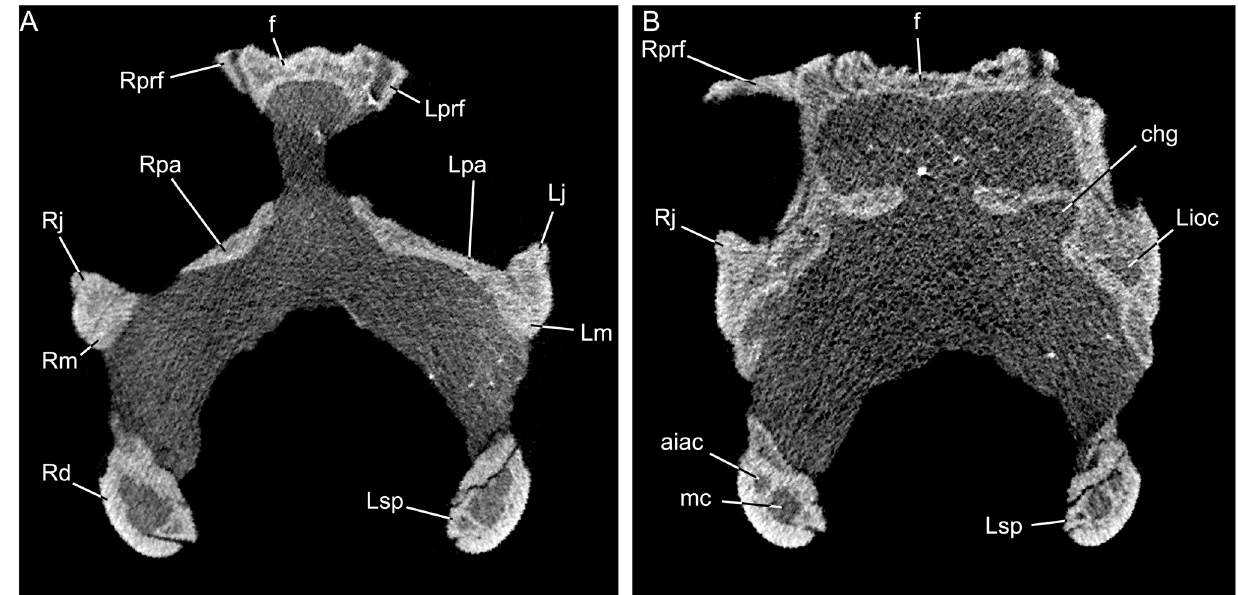
Fig 4. Transverse sections through the (A) orbital region and (B) preorbital region of Babibasiliscus alxi nov. taxon (UWBM 89090) illustrating details of bones and their